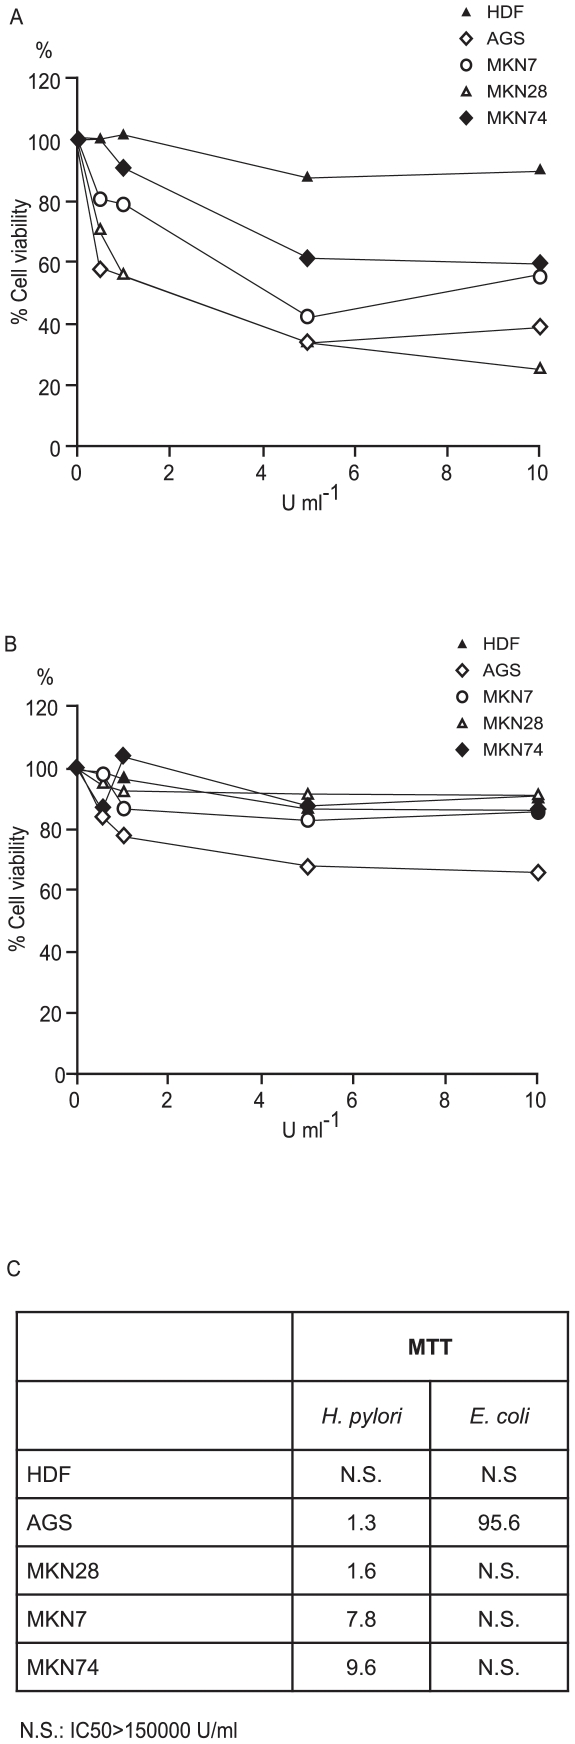
Cell-cycle inhibition by L-asparaginase.BrdU incorporation in cell lines exposed to variable concentration of recombinant H. pylori CCUG 17874 (A) and E. coli L-asparaginase (B) compared to untreated control cells. Boxes: magnification of the corresponding chart for L-asparaginase activities lower than 0.5 U ml−1. The points represent means (n≥3); SD not represented for clarity. (C) IC50 (L-asparaginase concentration inducing 50% cytotoxicity in U ml−1) of H. pylori and E. coli L-asparaginase (MTT assay).